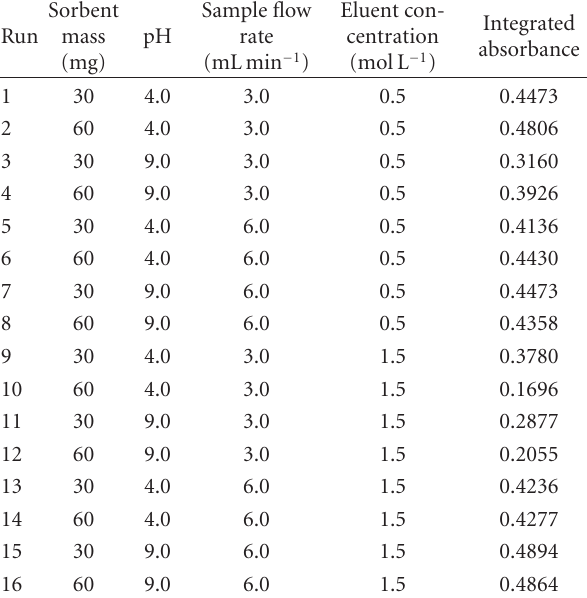
Pareto chart of standardized e ff ects; variable: absorbance